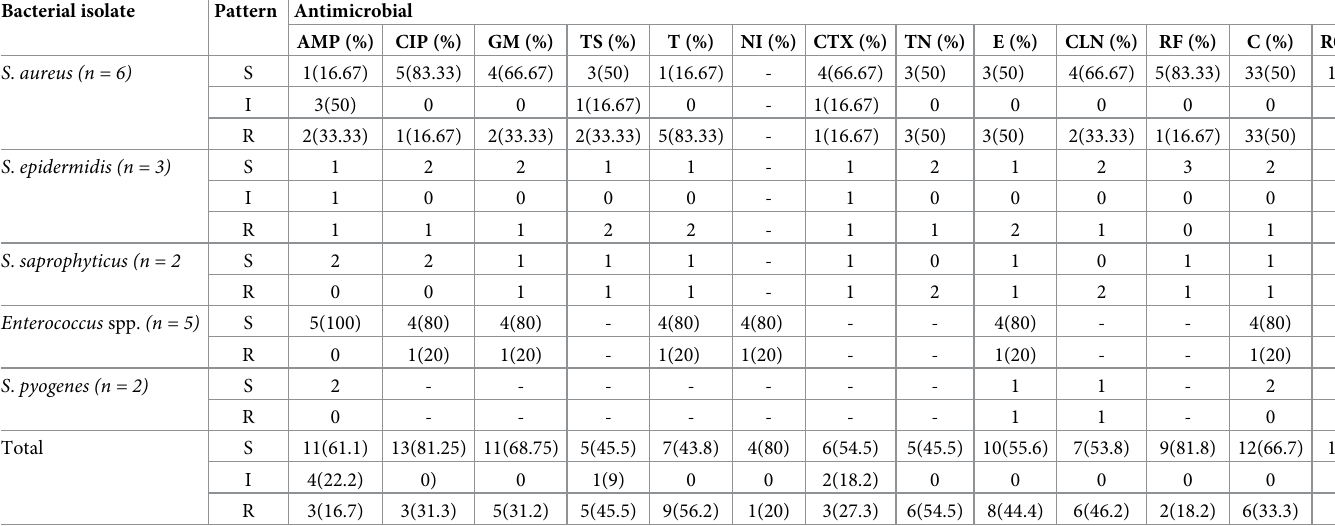
Table 5. Antimicrobial susceptibility pattern of gram-positive bacteria isolated from the urine of under-five children at HFSUH, eastern Ethiopia, 2021. Bacterial isolate Pattern